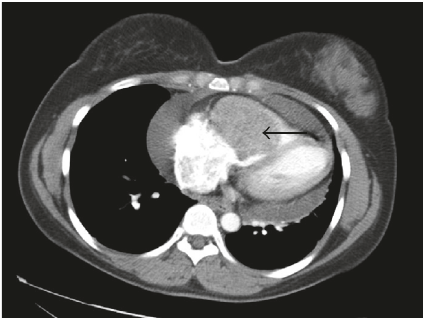
Figure 1: Computerized tomography of chest with contrast showing a large right ventricular mass (arrow) and pericardial effusion.